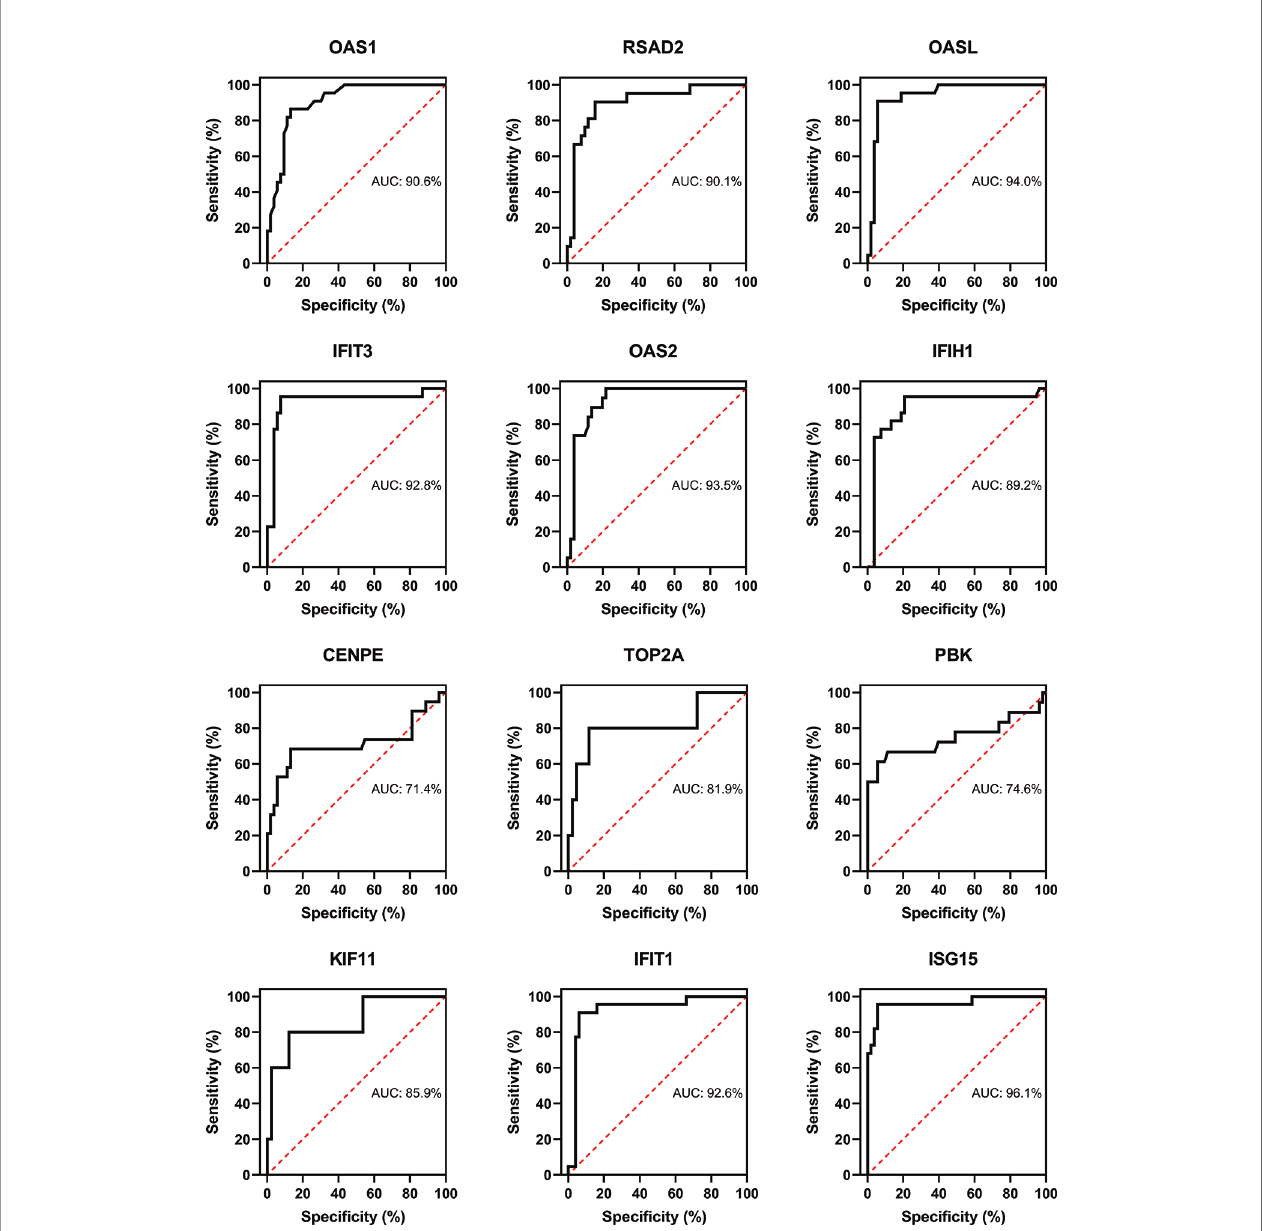
FIGURE 12 | Con fi rmation of SLE hub genes by ROC analysis. Out of 30 genes of immune cells fi ltered by MCODE, 12 genes having AUC > 0.70 were identi fi ed as biomarker genes for